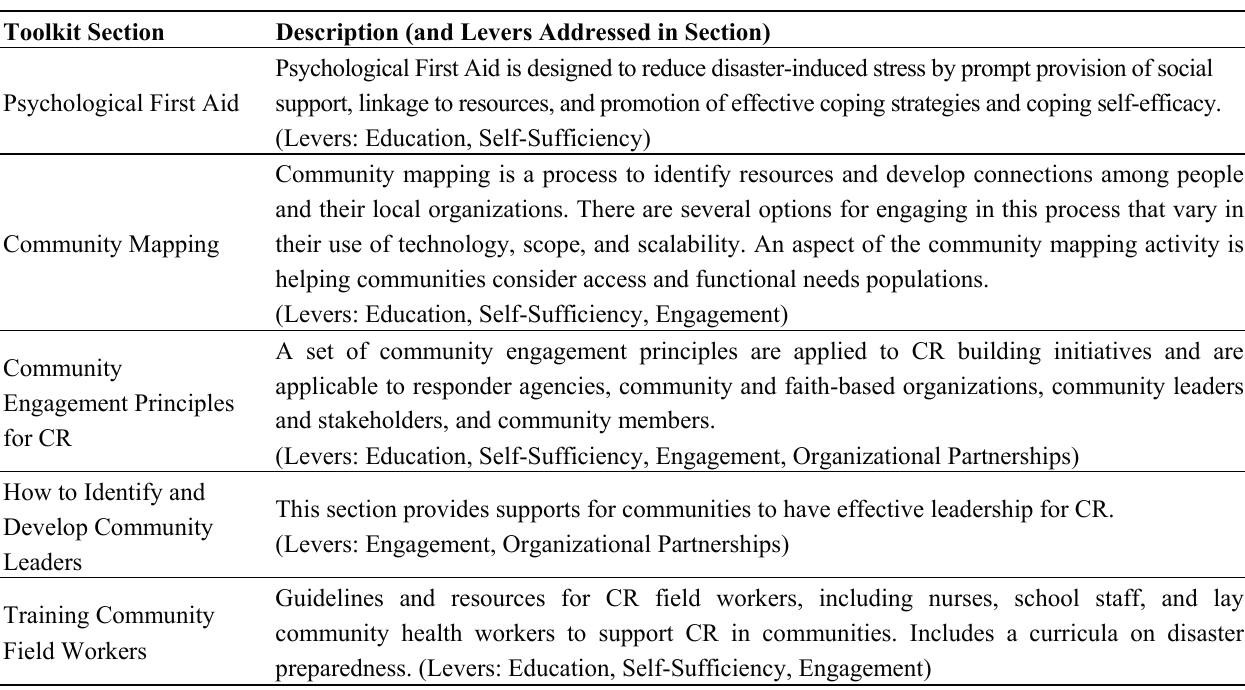
Table 2. Description of Community Resilience Toolkit in LACCDR